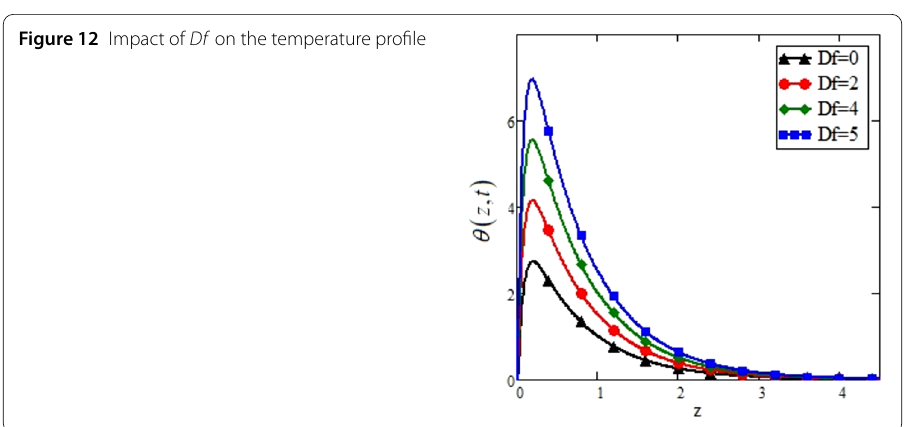
Nusselt number is identical to the variation in Table 2. The influence of Schmidt number on concentration profile is shown in Fig. 14. A fall in the concentration profile is